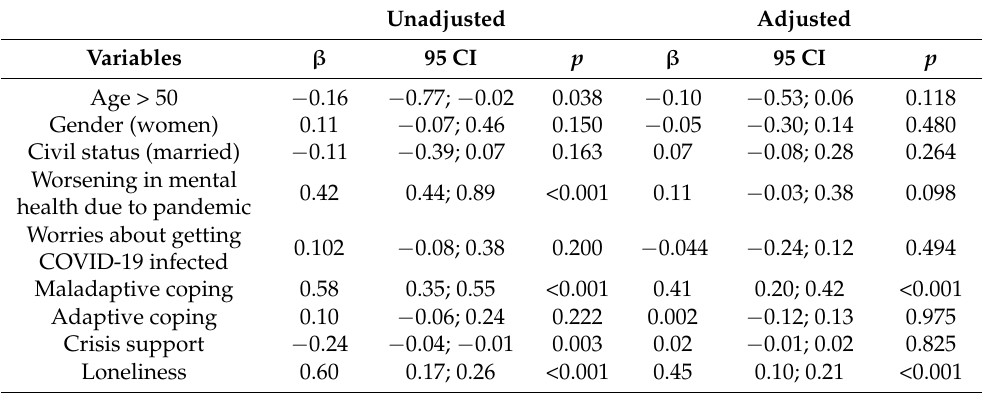
Table 3. Factors associated with depression symptoms according to HSCL-25 ( n =